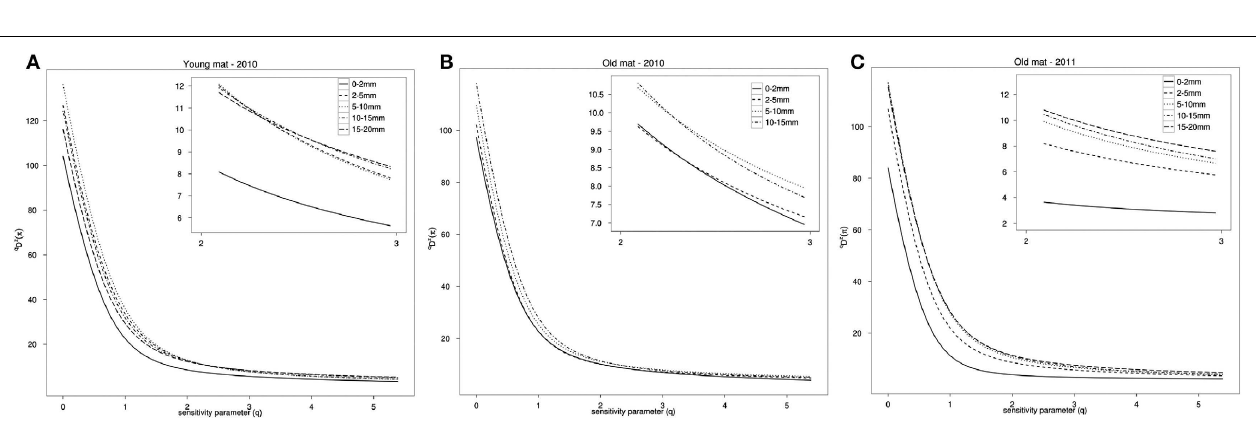
FIGURE 4 | Dendrogram of UniFrac distances clustered usingWard’s minimum variance method. Node labels are AU p -values.Values greater than 95 indicate significant clusters. Rectangles indicate the deepest significant clusters within each clade. OM, old mat;YM, young mat; 10, 2010; 11, 2011.